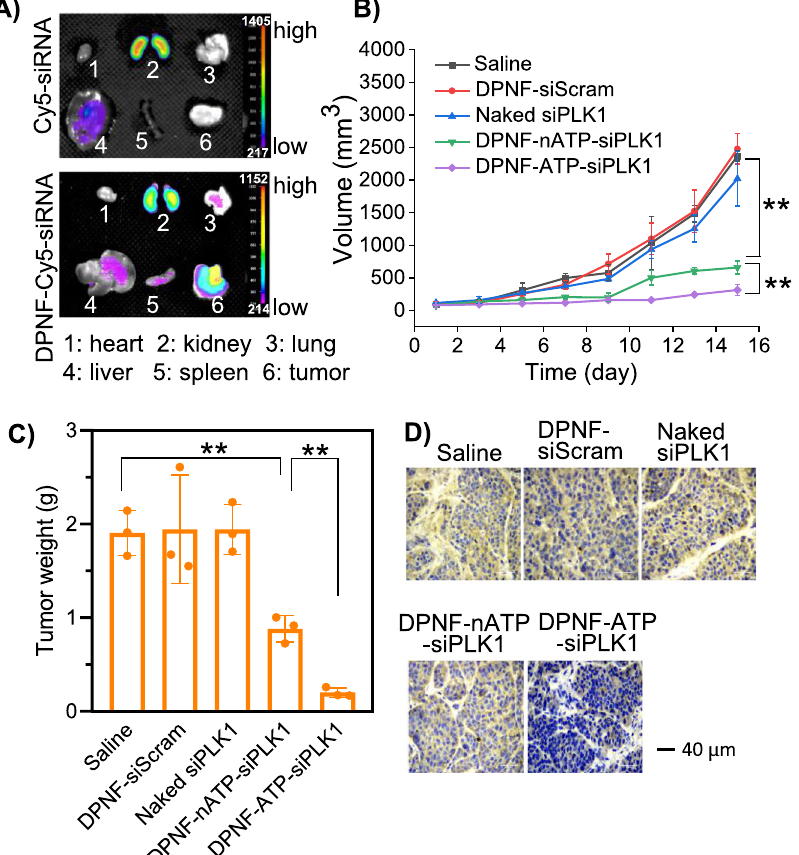
Fig. 7 In vivo targeting ability, antitumor, and gene knockdown effects of siPLK1-loaded DPNF in subcutaneous tumor model. A In vivo targeting, BALB/ c nude mice with subcutaneous xenografts (MDA-MB-231 cells) were injected through tail vein with Cy5-siRNA and DPNF-Cy5-siRNA, respectively. After 24 h, the mice were sacri fi ced and the tumor, kidney, liver, lung, spleen, and heart were removed for ex vivo imaging. B Tumor growth curves. ** p < 0.01. C Tumor weights measurement. ** p < 0.01. D Representative immunohistochemical staining of PLK1 protein in tumor tissue in various treatment groups. Data represent mean ± s.d. ( n = 3 independent